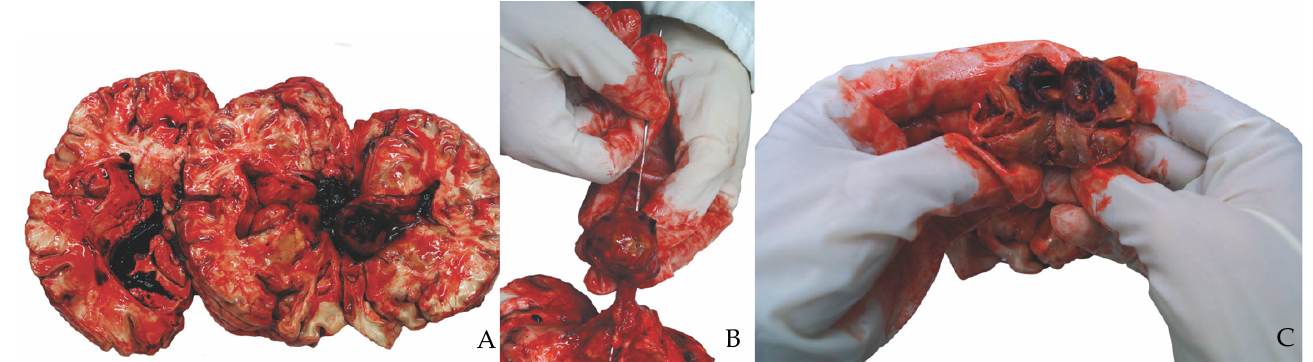
Figure 1. Autopsy findings. ( A ) the brain after sectioning: blood congestion and the tissue mass inside the right ventricle; ( B , C ) the tissue mass with fibrous capsule, in the right lateral ventricle, close to right choroidal plexus.